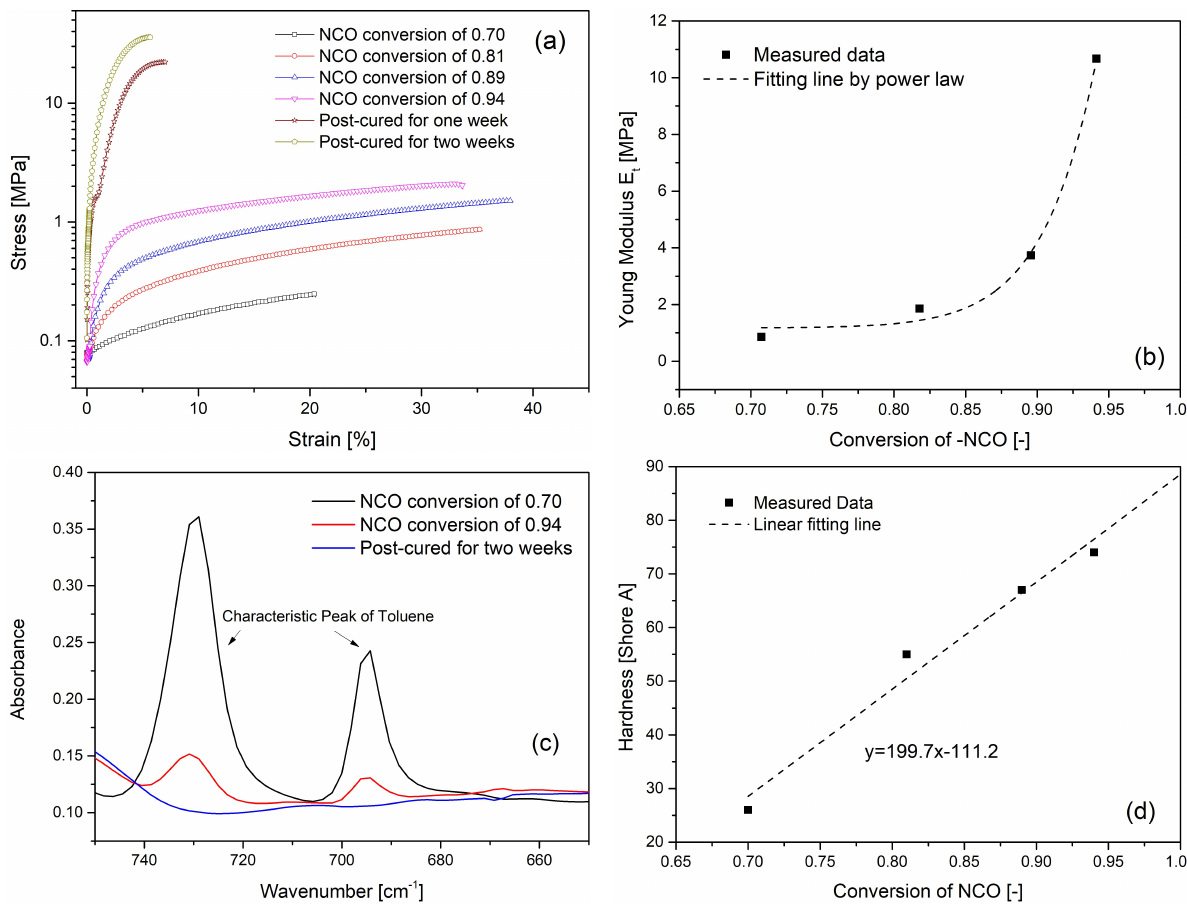
Figure 9: Tensile properties of PU with different degrees of NCO-conversion in stress-strain diagram (a), tensile modulus diagram (b), and characteristic peak of toluene in the FTIR spectrum (c), and Shore A hardness as a function of NCO-conversion (d)